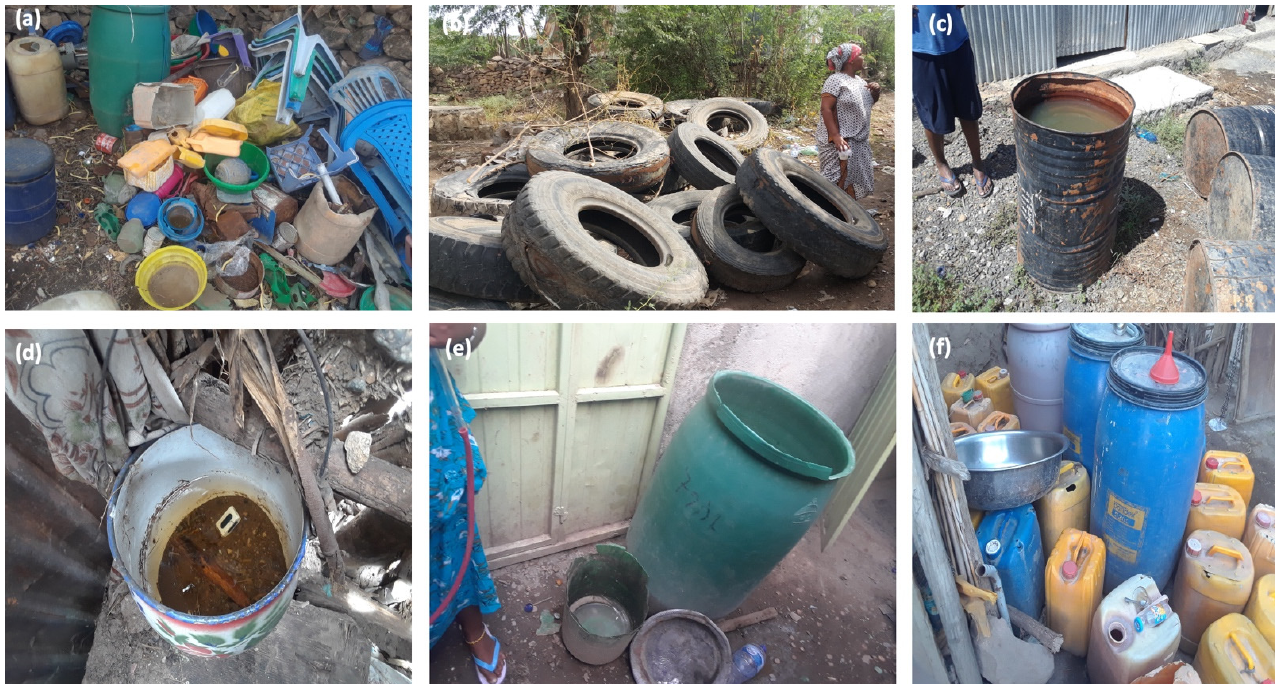
Figure 4. Typical Aedes breeding sites identified in Gewane District, Ethiopia, 2019: ( a ) plastic buckets/bowls; ( b ) rubber tires; ( c ) metal drum; ( d ) pots; ( e ) large plastic tanks; and ( f ) small plastic tanks.